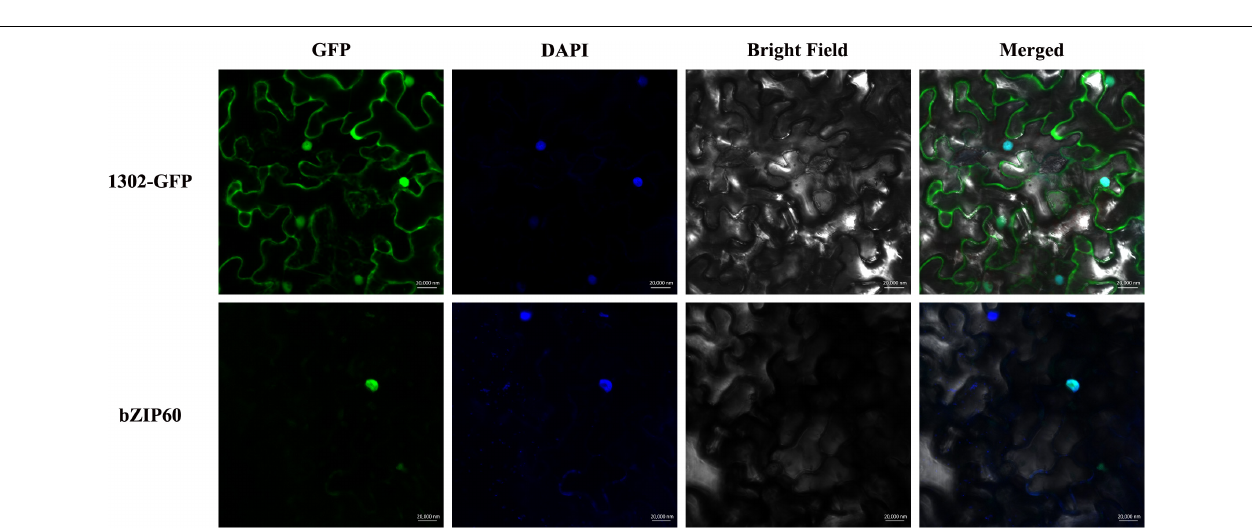
Frontiers in Plant Science |